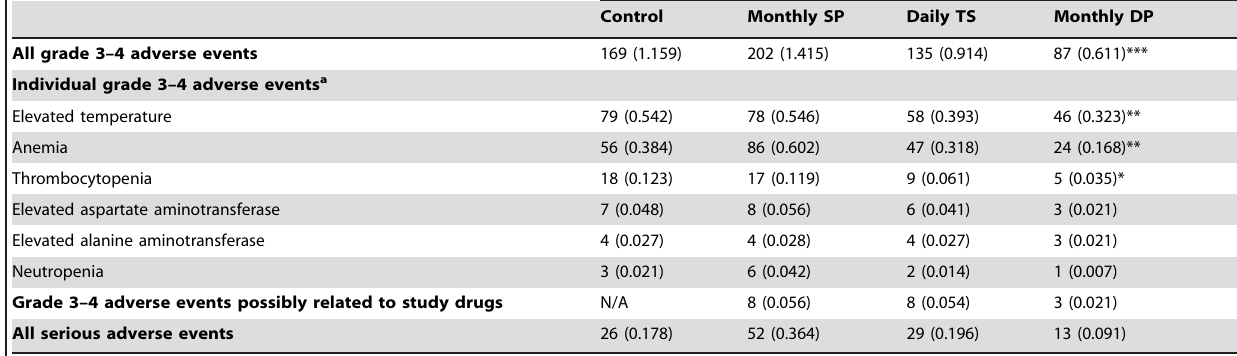
Table 5. Comparative safety outcomes.